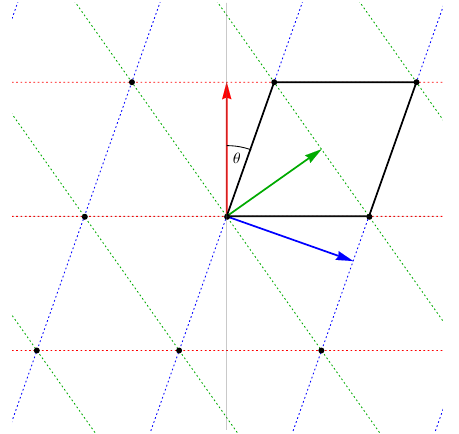
Figure 1 . The fundamental torus region is given by the solid black parallelogram with side lengths L , which is angled at (cid:18) = arcsin (cid:13) . The arrows show the longest wavelength wavevectors 2 (cid:25)~k= j k j 2 that generate parallel lines in the